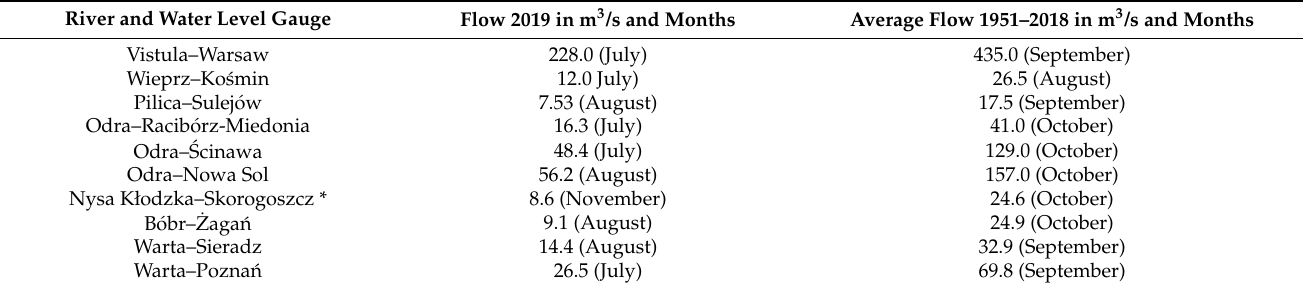
Table 4. Months with the lowest flow in 2019 compared to the 1951–2018 multi-year period. River and Water Level